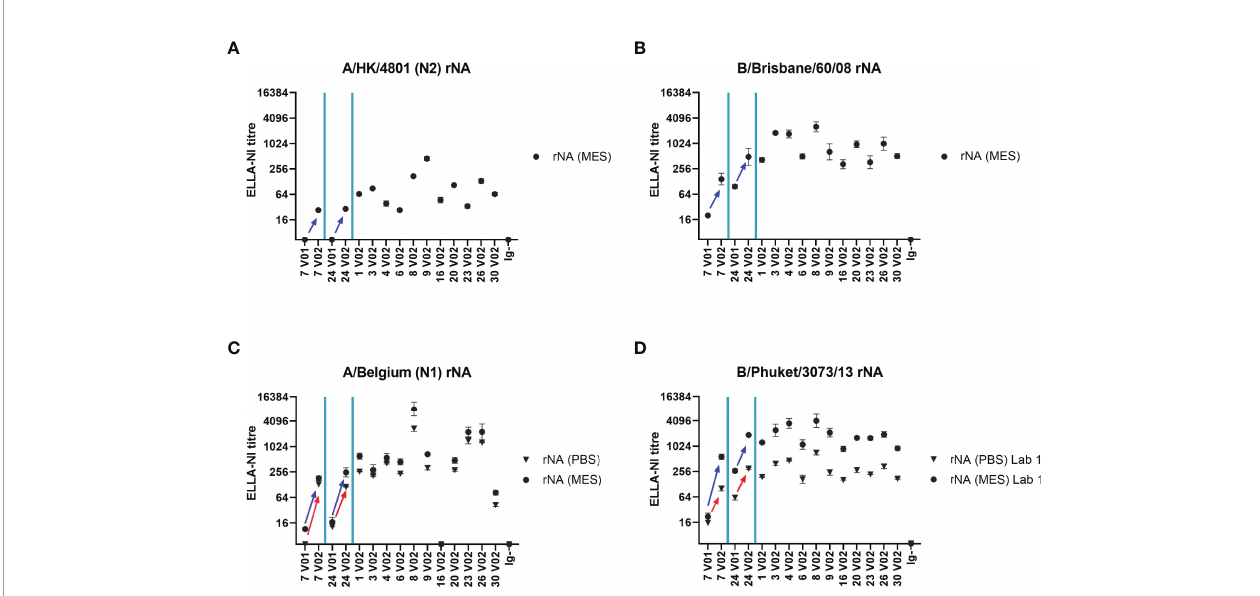
FIGURE 7 | Recombinant NA (rNA) antigen in ELLA-NI. A panel of 16 human sera were titrated in ELLA-NI using rNA from (A) A/Hong Kong/4801/2014 (N2) (B) B/ Brisbane/60/2008 (C) A/Belgium/145-MA/2009 (N1) and (D) B/Phuket/3073/2013 using either MES (circles, all four rNAs tested) or PBS (triangles, A/Belgium and B/Phuket only) based-buffers. Paired pre- (V1) and post- (V2) vaccination sera from two individuals (7 and 24) were included in the serum panel. Increases in ELLA-NI titres after vaccination are indicated by arrows (blue for MES buffer and red for PBS buffer). GMT of 2-4 independent titrations is plotted with geometric SD error